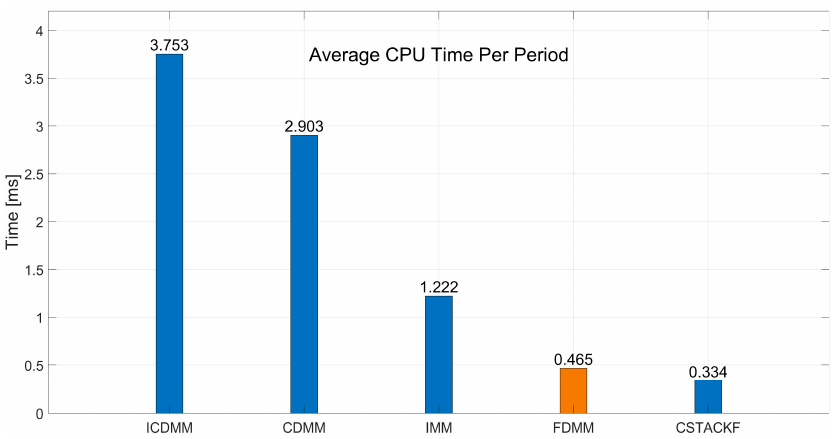
Figure 13. The average CPU time per period for different algorithms in Case 2.